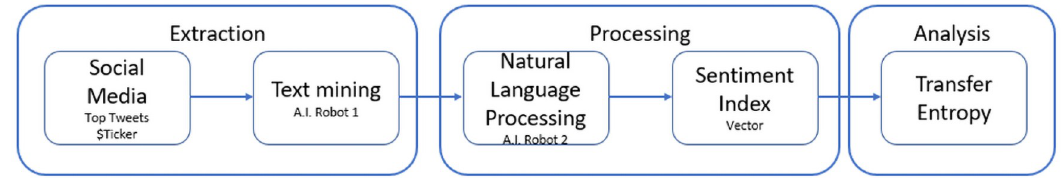
Fig 1. Framework model in which we present the 3 processes developed in order to obtain, structure and analyze the information.